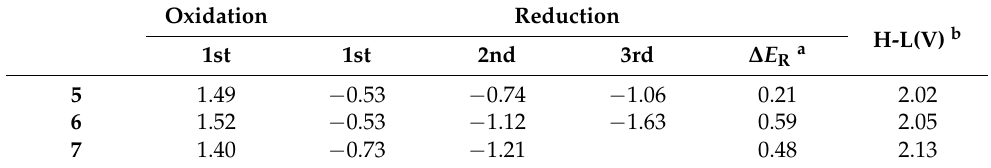
Figure 3. Cyclic voltammograms of 5 – 7 in CH 2 Cl 2 containing 0.1 M TBAP (( a ) 5 ; ( b ) 6 ; and ( c ) 7 ). Table 1. Half-wave potential (V vs. SCE) of 5 – 7 in CH 2 Cl 2 containing 0.1 M